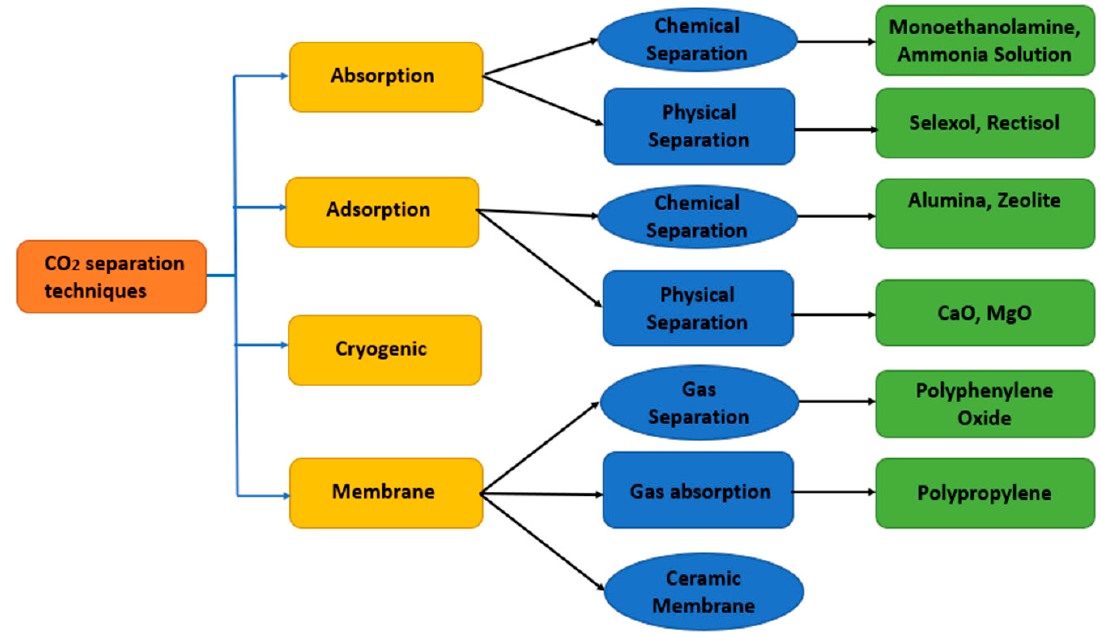
Figure 8. Di ff erent technologies for CO 2 separation Figure 8. Different technologies for CO 2 separation [24].